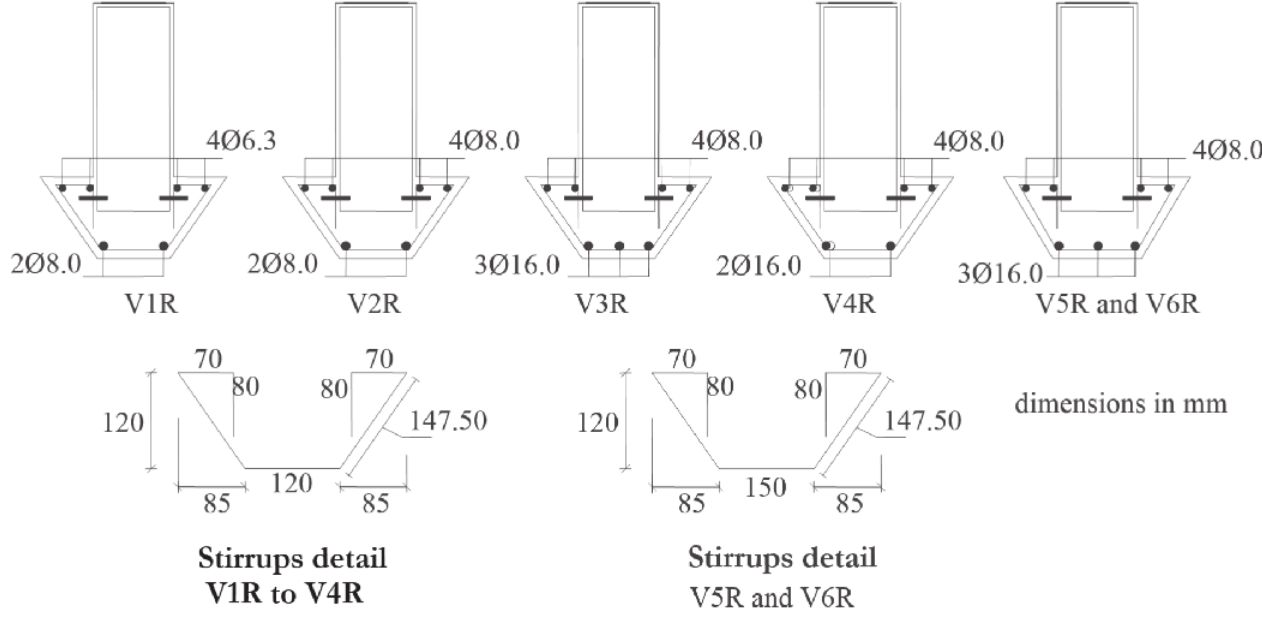
Reinforcement in the jackets of beams V1R to V6R